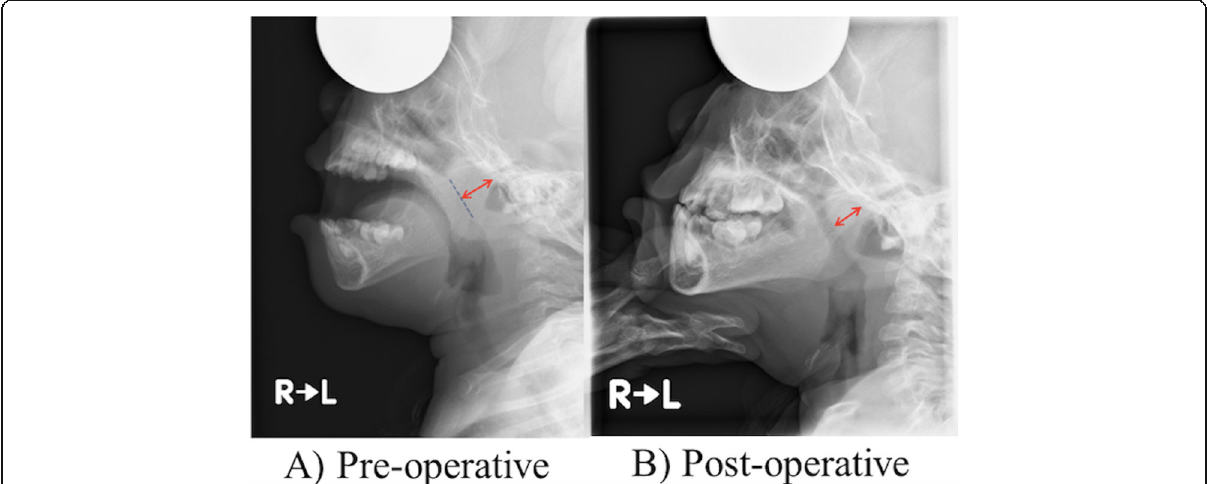
Fig. 2 Pre- and postoperative lateral-view radiographs of the nasopharynx. a Preoperative image. b Postoperative image. Bloated adenoids ( a : arrow) encroach on and severely obstruct the nasopharyngeal airway ( a : dotted line). After tonsillectomy ( b : arrow), the nasopharyngeal airway is open, allowing the patient to breathe with the mouth